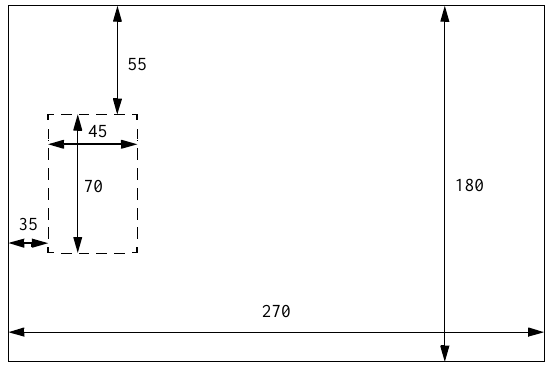
Fig. 1. Dimensions (in mm) of the delaminated polyester plate. The dotted line denotes the delaminated area.